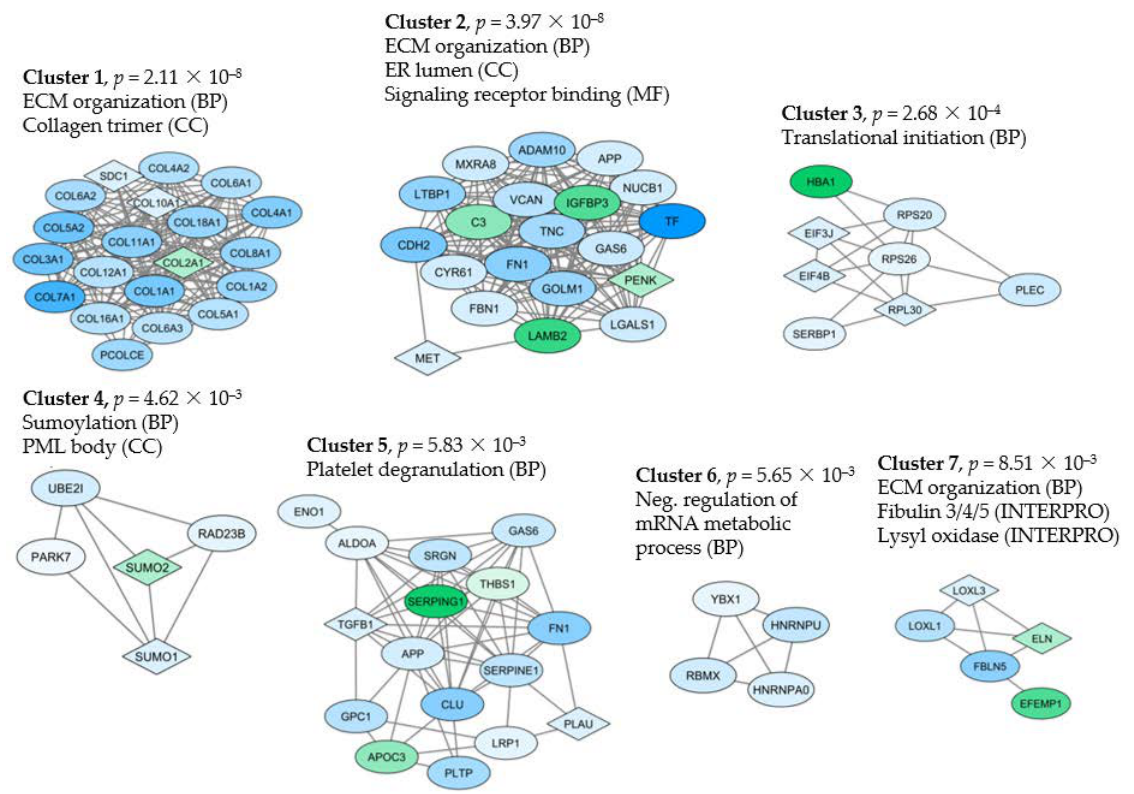
Figure 3. Network identification based on proteins that differed significantly when comparing the constitutive release by MSCs and osteoblasts (i.e., showing statistically significant differences or being exclusively released by only one cell type, see Section 2.5). The proteins were imported into the String database to identify interacting proteins, and the String network was imported to Cytoscape where the ClusterOne application was used to find protein clusters with high cohesiveness (Clusters 1–7). Proteins with higher abundance in MSCs are shown in blue, while green indicates higher abundance in osteoblasts (indicated to the lower left in the figure). GO terms were identified by the String database (BP, biological processes; CC, cellular compartments; MF, molecular functions; square symbols indicate that the protein is classified as unique for the indicated cell